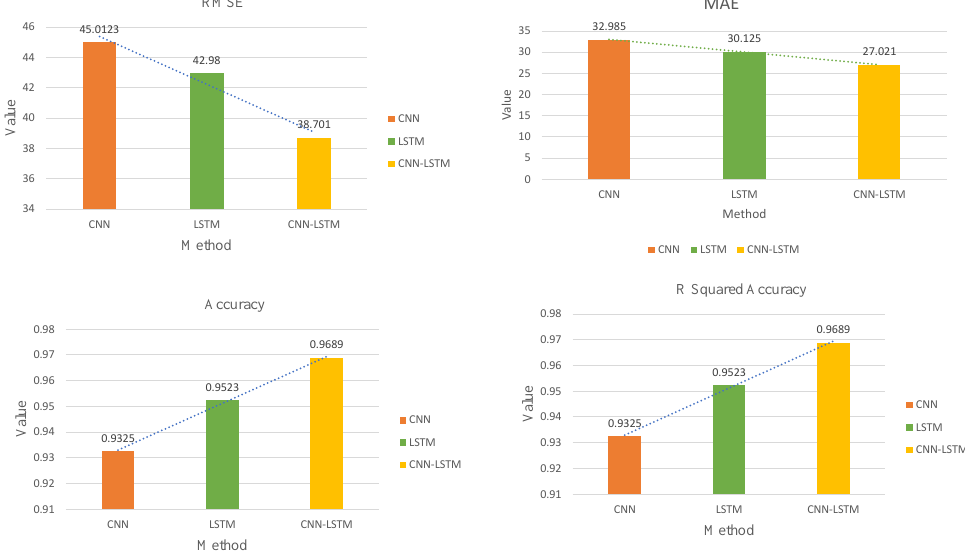
Figure 9. Overall comparison of different metrics used to evaluate CNN-LSTM